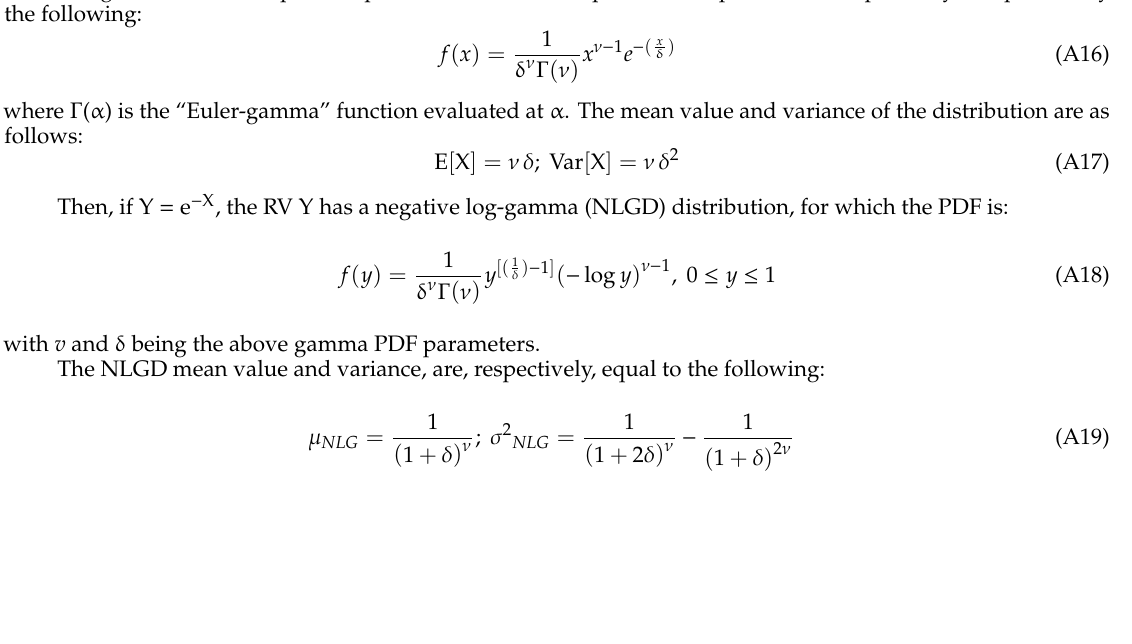
Figure A2. IRD fitting PDF for the data histogram of EWS data in Table